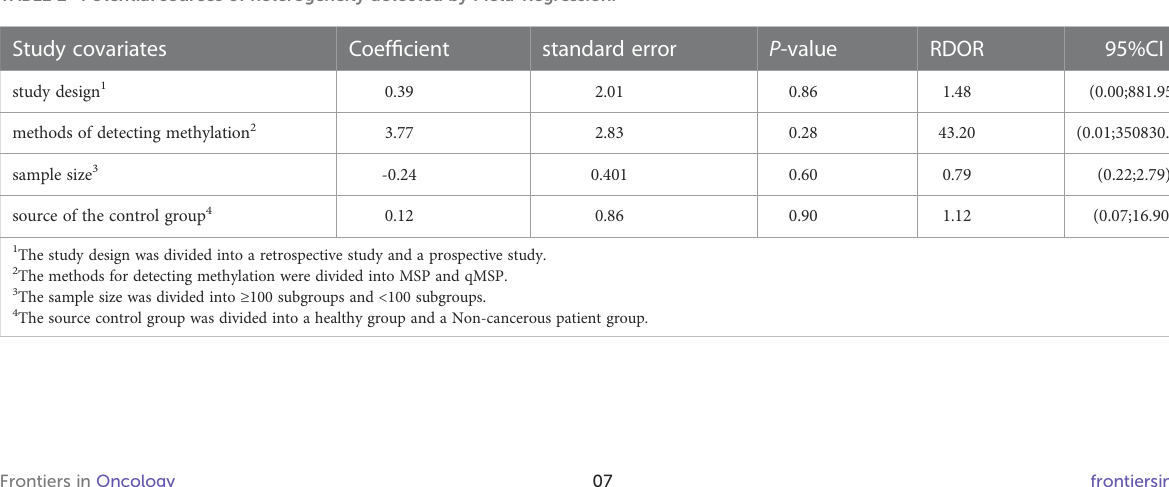
TABLE 2 Potential sources of heterogeneity detected by